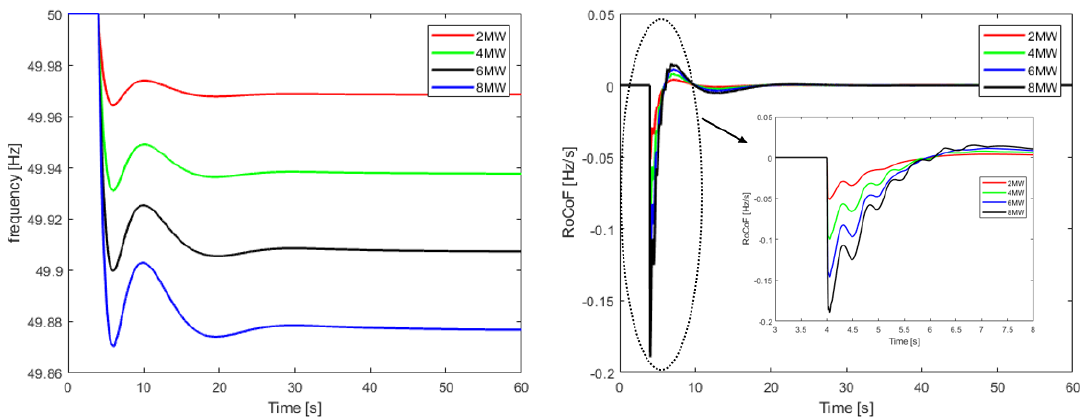
Figure 10. Load step-change frequency response and RoCoF for the worst case of the future scenario.